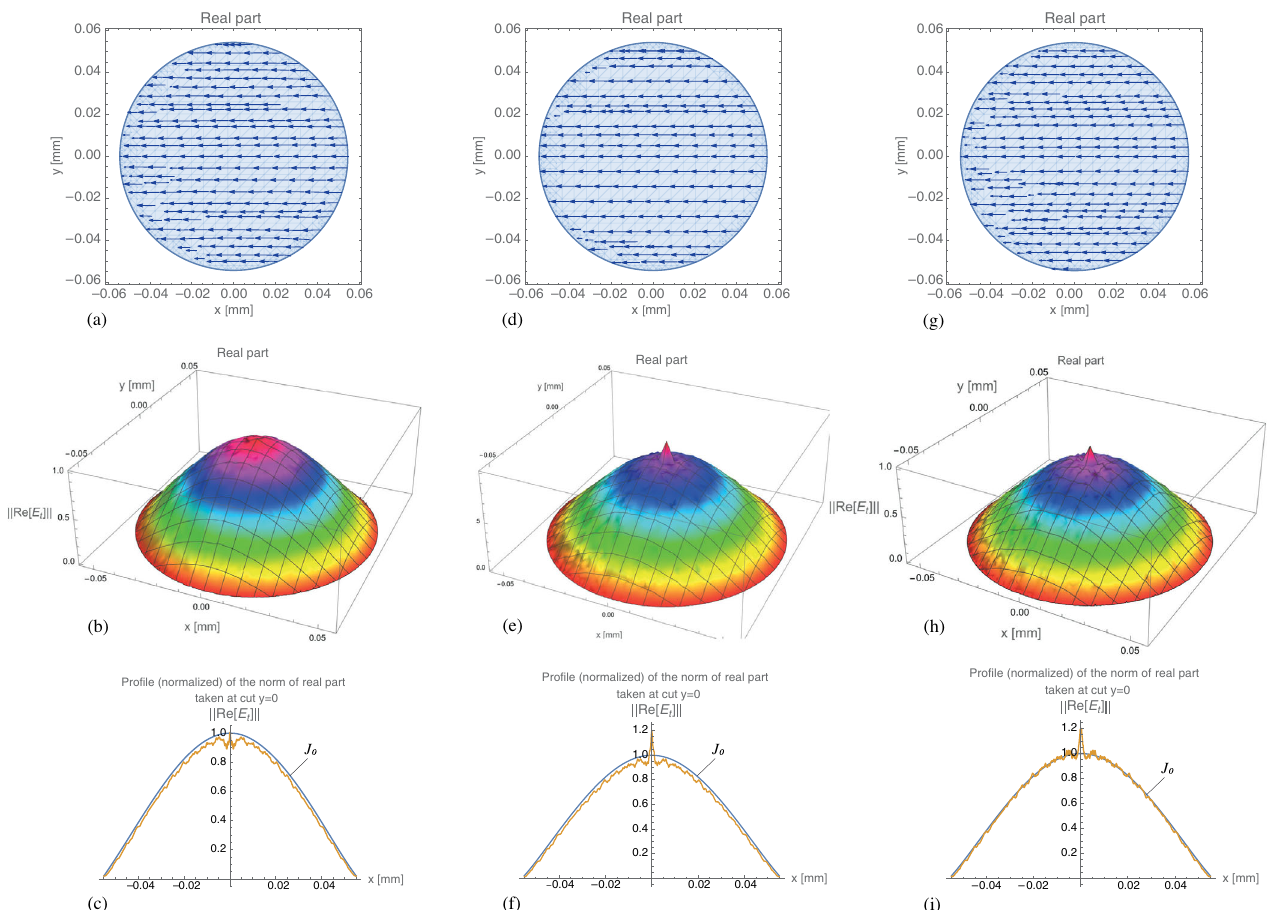
FIG. 10. Scale-3 field polarization and amplitude profile plots, calculated at pSteps=nSteps ¼ 6666 = 3333 and plotted at nSteps ¼ 1111 : (a) – (c) for δ ¼ 0 mm, (d) – (f) for δ ¼ 2 mm, and (g) – (i) for δ ¼ 10 mm. The polarization and amplitude profiles seem unaffected by the small increase in screen thickness. Subplots (c), (f) and (i) show E -field amplitude profile cuts at the y ¼ 0 plane across the iris, compared to the idealized shape of the J 0 ð 2 . 4 r=a Þ function. A small sharp spike is observed in the amplitude profile in (f) and (i), which may be a result of low numerical